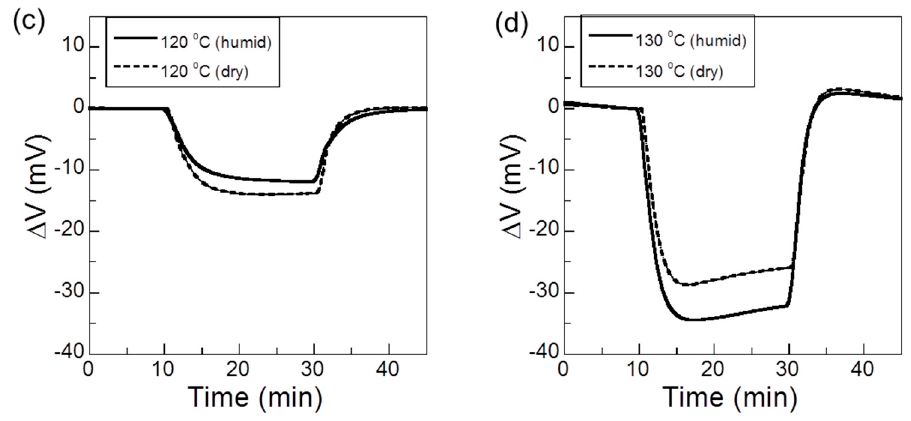
Figure 2. Sensor responses to 25,000 ppm H 2 in humid and dry air at ( a ) 80 °C; ( b ) 100 °C; ( c ) 120 °C; and ( d ) 130 °C.